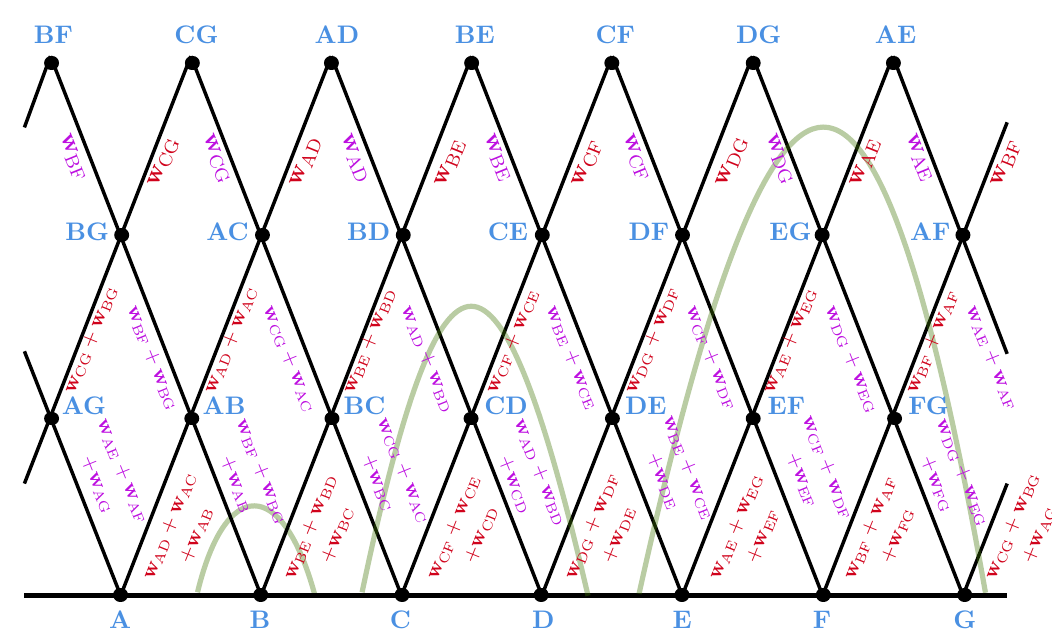
Figure 10 . The diamondwork construction for N = 7 atomic regions. The boundary, at the bottom, is a circle, and so the left and right edges of the figure are identified. The k th layer inward from the boundary ( k th layer upward in the figure) has one vertex for each contiguous size- k region. Each vertex is connected inwards (up in the figure) to the vertices representing the two contiguous regions of size k + 1 it is contained in, and outwards (down in the figure) to the two contiguous regions of size k − 1 it contains. For example, the vertex CE , representing the size-3 contiguous region CDE , is connected inwards to BE and CF , and outwards to CD and DE . The graph for N atomic regions has N vertices per layer, and ( N + 1) / 2 layers when N is odd (the case where N is even is slightly more complicated). The weight of an edge is obtained from the weights w ij of the bulkless graph by extending the edge inward and taking the sum of the weights corresponding to the vertices the extended edge hits. For example, the weight of the edge connecting BC to AC , which extends through AC to CG , is therefore w + w . As argued in the text, this means AC CG that min-cuts in the diamondwork graph have the same weights as min-cuts in the bulkless graph. Min-cuts for the boundary regions B , CD , and EFG are shown in the